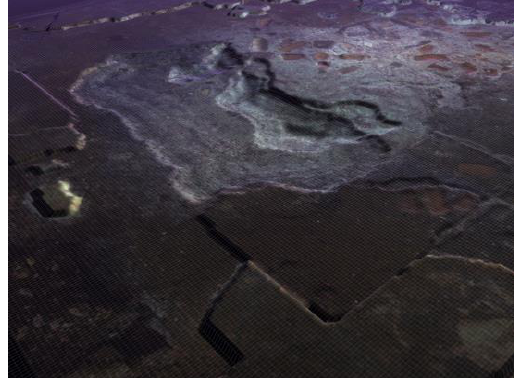
Fig. 4 - The opus sectile floor: 3D results (ISCR Archive)